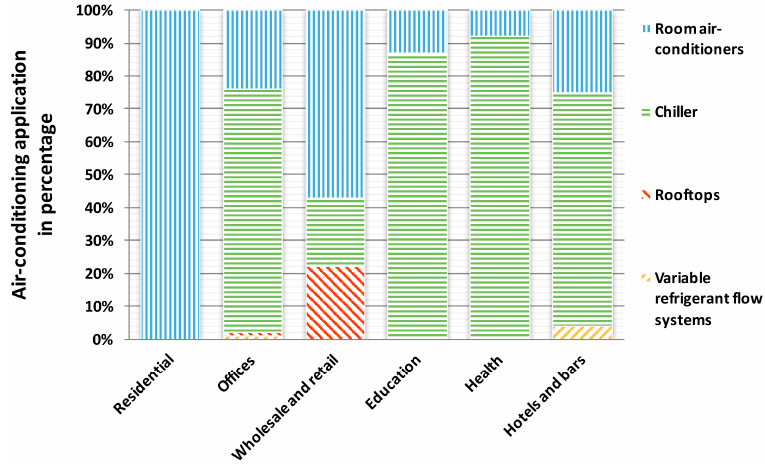
Figure 4. Distribution of installed AC application by sector and type, EU15 [13,43,44].